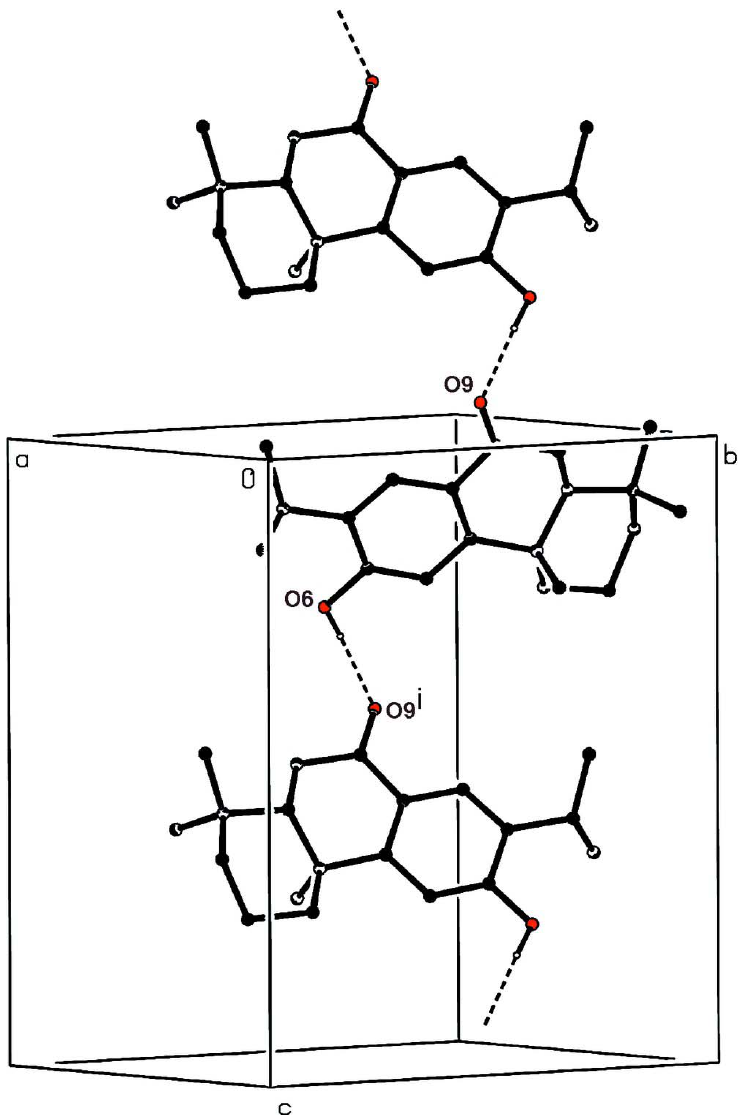
Partial packing view of the compound, showing the formation of the zig zag chain parallel to the c axis and built from O —H···O hydrogen bonds. H atoms not involved in hydrogen bonding have been omitted for clarity. [symmetry codes: (i) - x + 1/2,- y + 1, z +